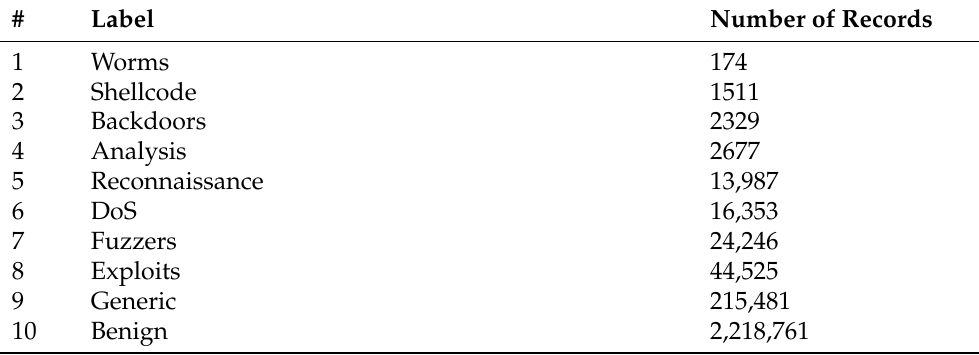
Table 4. USNW-NB15 dataset record